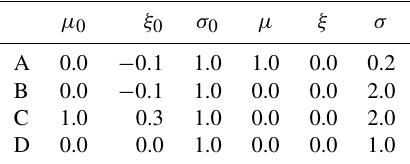
Table 2. Different simulation scenarios for Setting